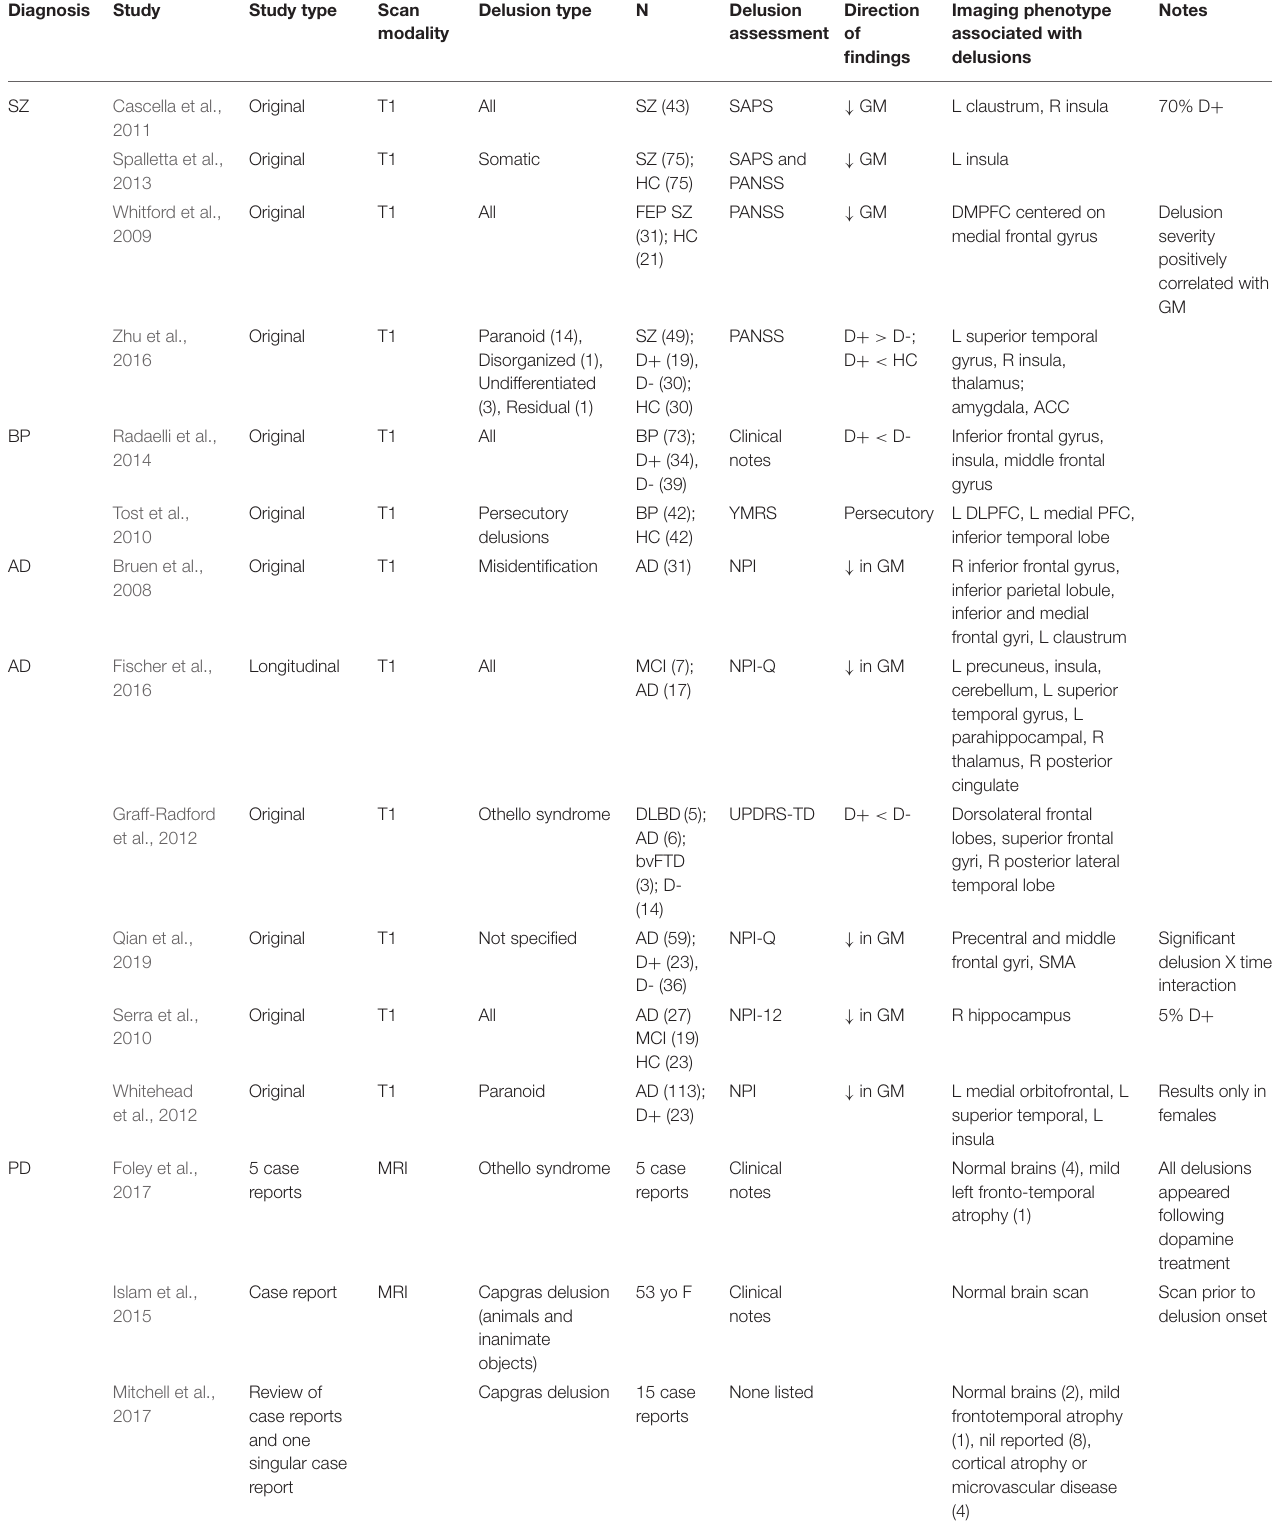
TABLE 1 | Original structural imaging studies and phenotypes associated with